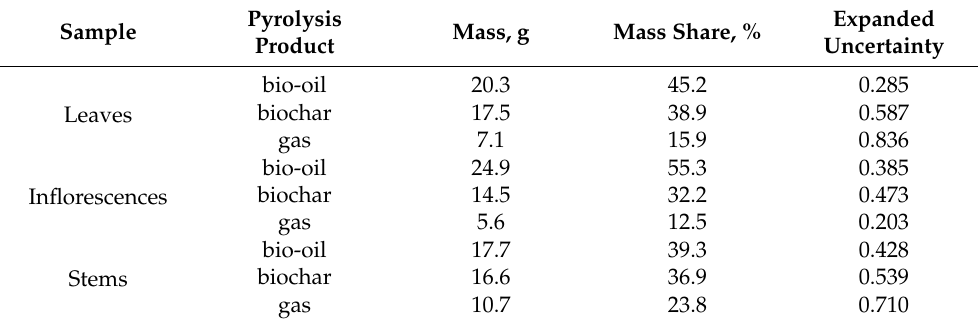
Table 4. Distribution of product pyrolysis yields and uncertainty